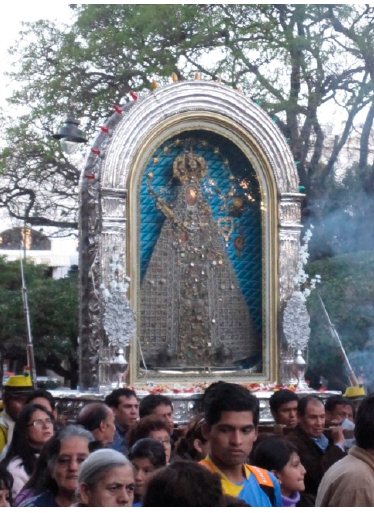
Figure 3. Procession of the Virgin of Guadalupe (photo: Andrea Nicklisch).